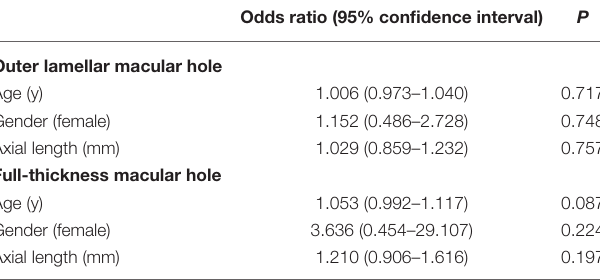
TABLE 3 | Univariate analysis of systemic and ocular characteristics for outer lamellar macular holes and full-thickness macular holes.